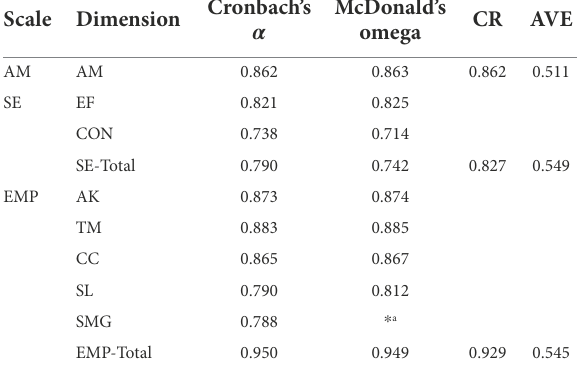
TABLE 1 Reliability and validity of the scale.